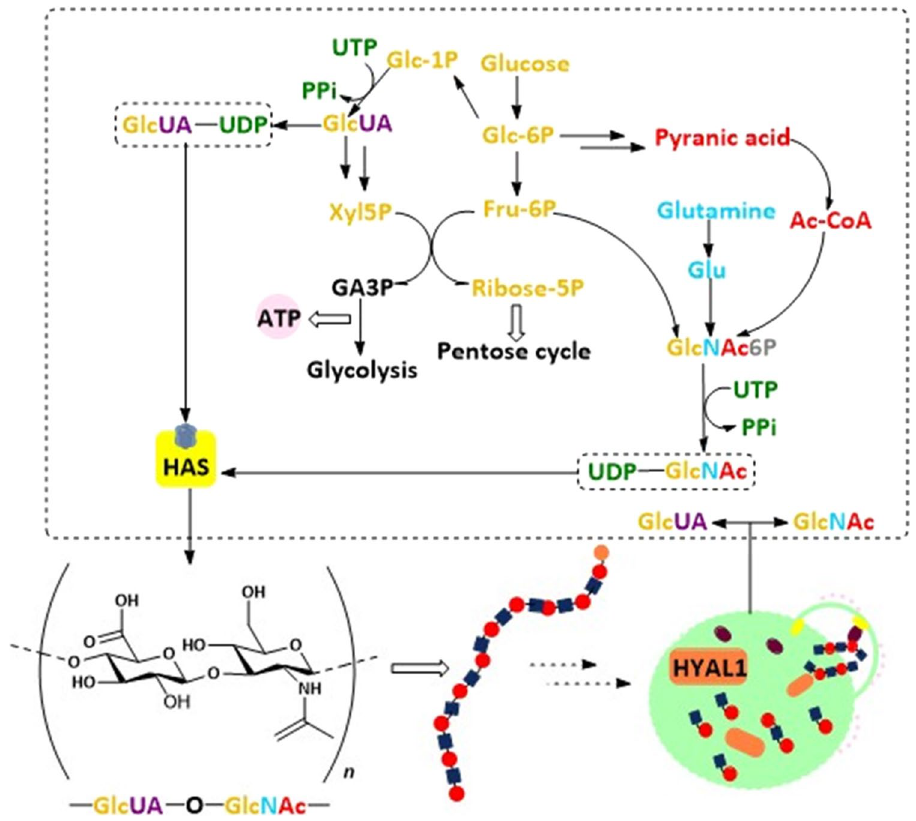
Fig. 4 The energy metabolism of HA. The origins and decom- position of 2 substrates, GlcNAc and GlcUA, respec- tively. The ingredients consist of GlcNAc come glucose, glutamine and pyranic acid, and then UTP provides energy and attaches to GlcNAc. The glycosyl structure in GlcUA also comes from glucose as GlcNAc. In addition, GlcUA could also generate energy by entering glycolysis and the pentose cycle. The residues with different color track their source. The lower left displays a single unit of HA with a disaccharide structure. The lower right briefly flashback the final step of hydrolysis in lysosome where recycles GlcNAc and GlcUA to the